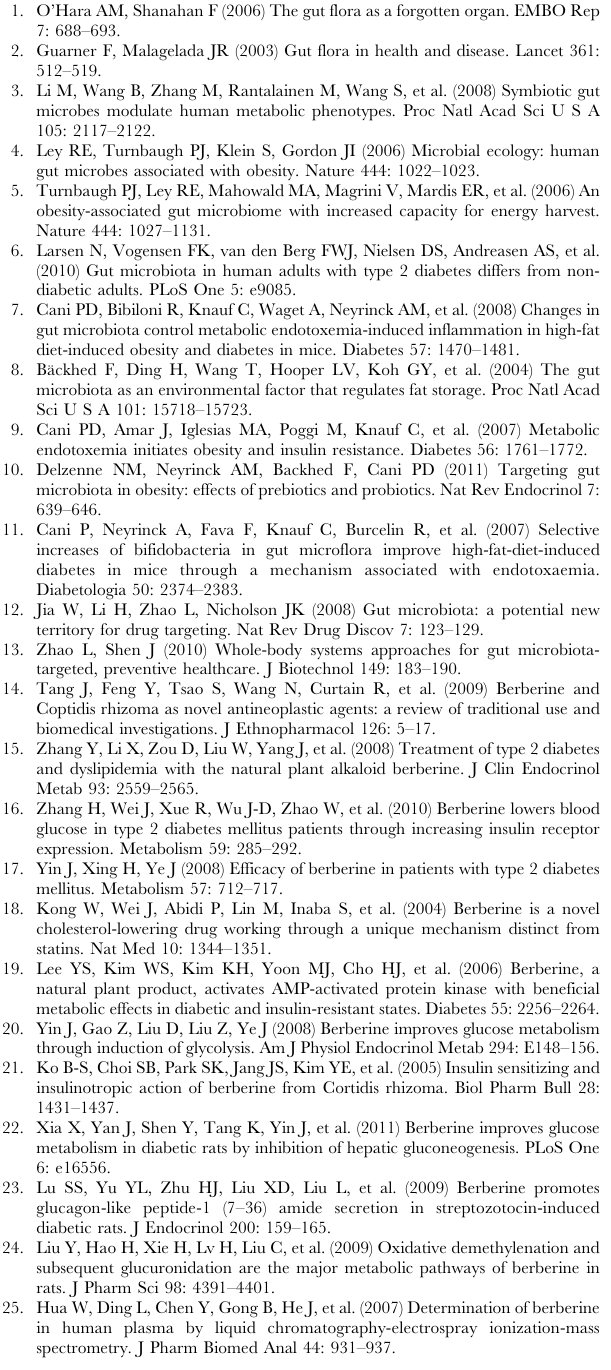
Table S1 Significantly different phyla or genera between groups as revealed by taxon-based comparisons. Table S2 Taxonomic assignments of 268 key OTUs identified by RDA.